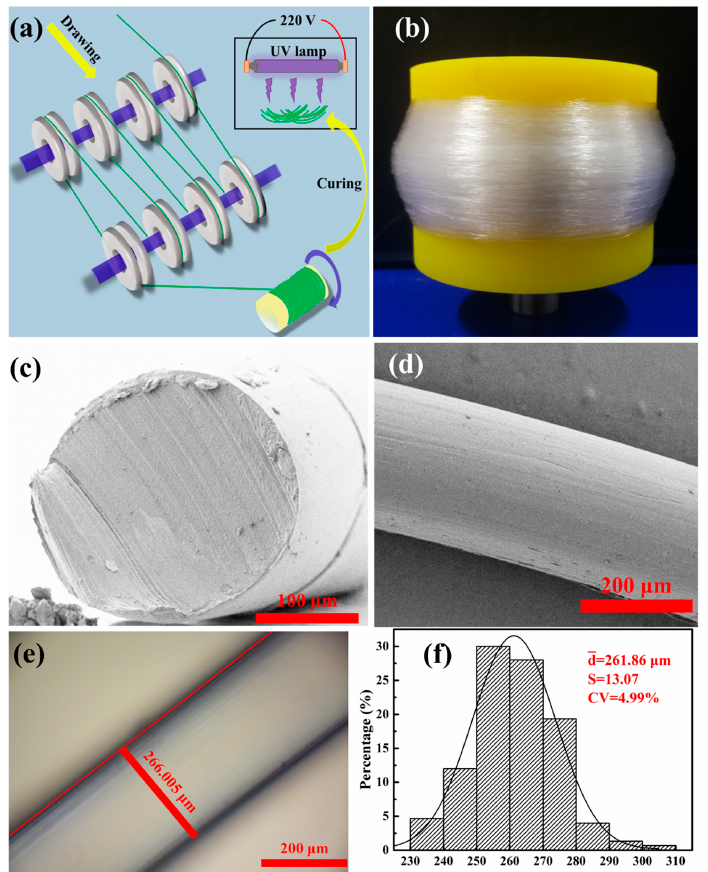
Figure 1. ( a ) Preparation schematic of drawing and ultraviolet (UV) curing; ( b ) digital photograph of ethylene-vinyl acetate (EVA) fiber before UV curing; ( c , d ) the SEM images of EVA fiber after UV curing; ( e , f ) the optical micrograph and diameter distribution of EVA fiber after UV curing.